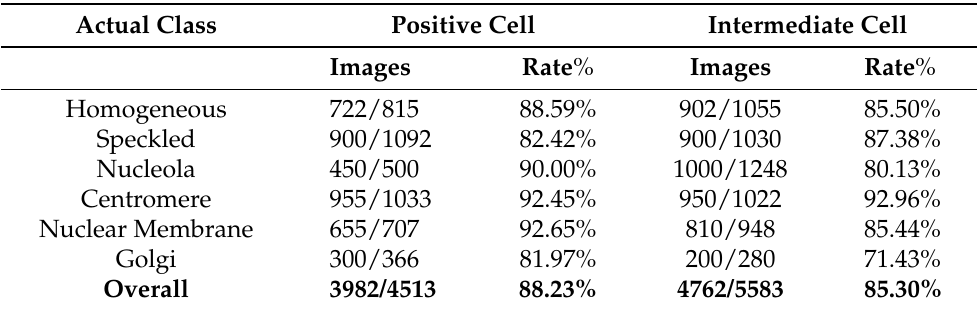
Table 1. Accuracy of positive/intermediate cells for each class and the number of images which is classified correctly from test images.